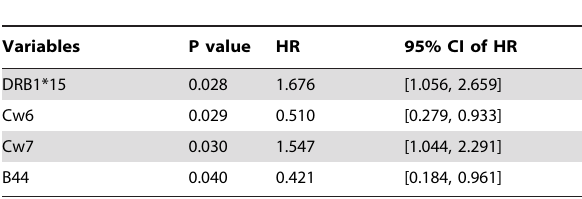
Table 2. Univariate overall survival (OS) analysis.